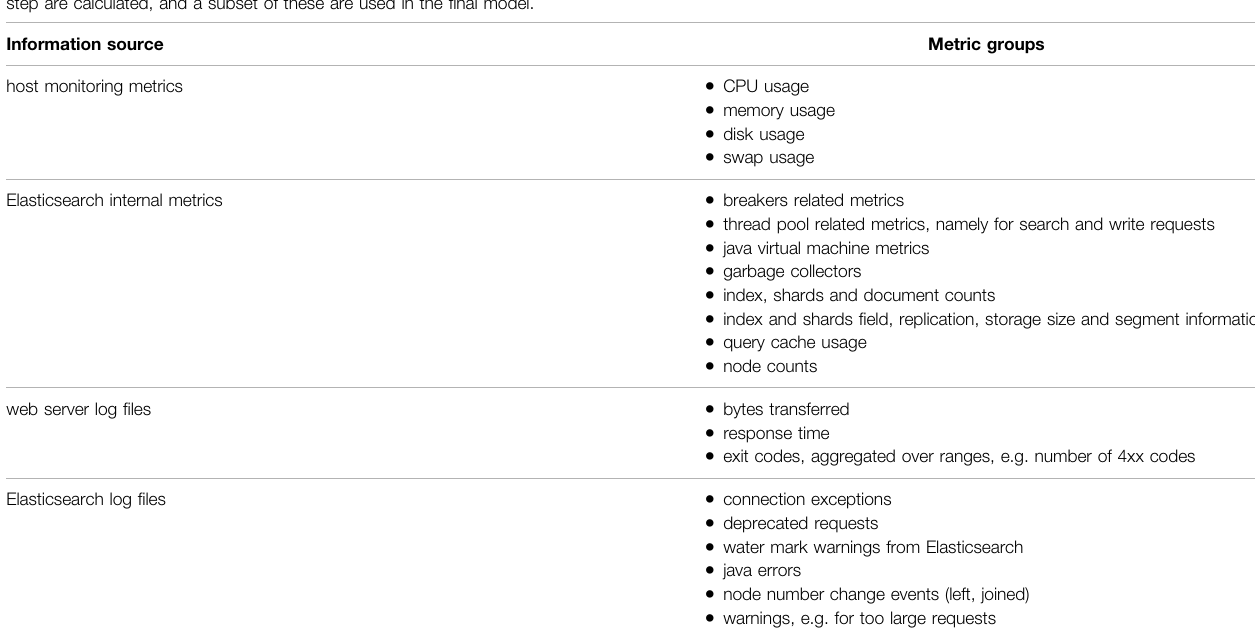
TABLE1| Sourcesandclassesofinputmetrics.Duringtheenrichmentsteps,averages,maximumandminimumvaluesaswellaschangeswithrespecttotheprevioustime step are calculated, and a subset of these are used in the fi nal model. Information